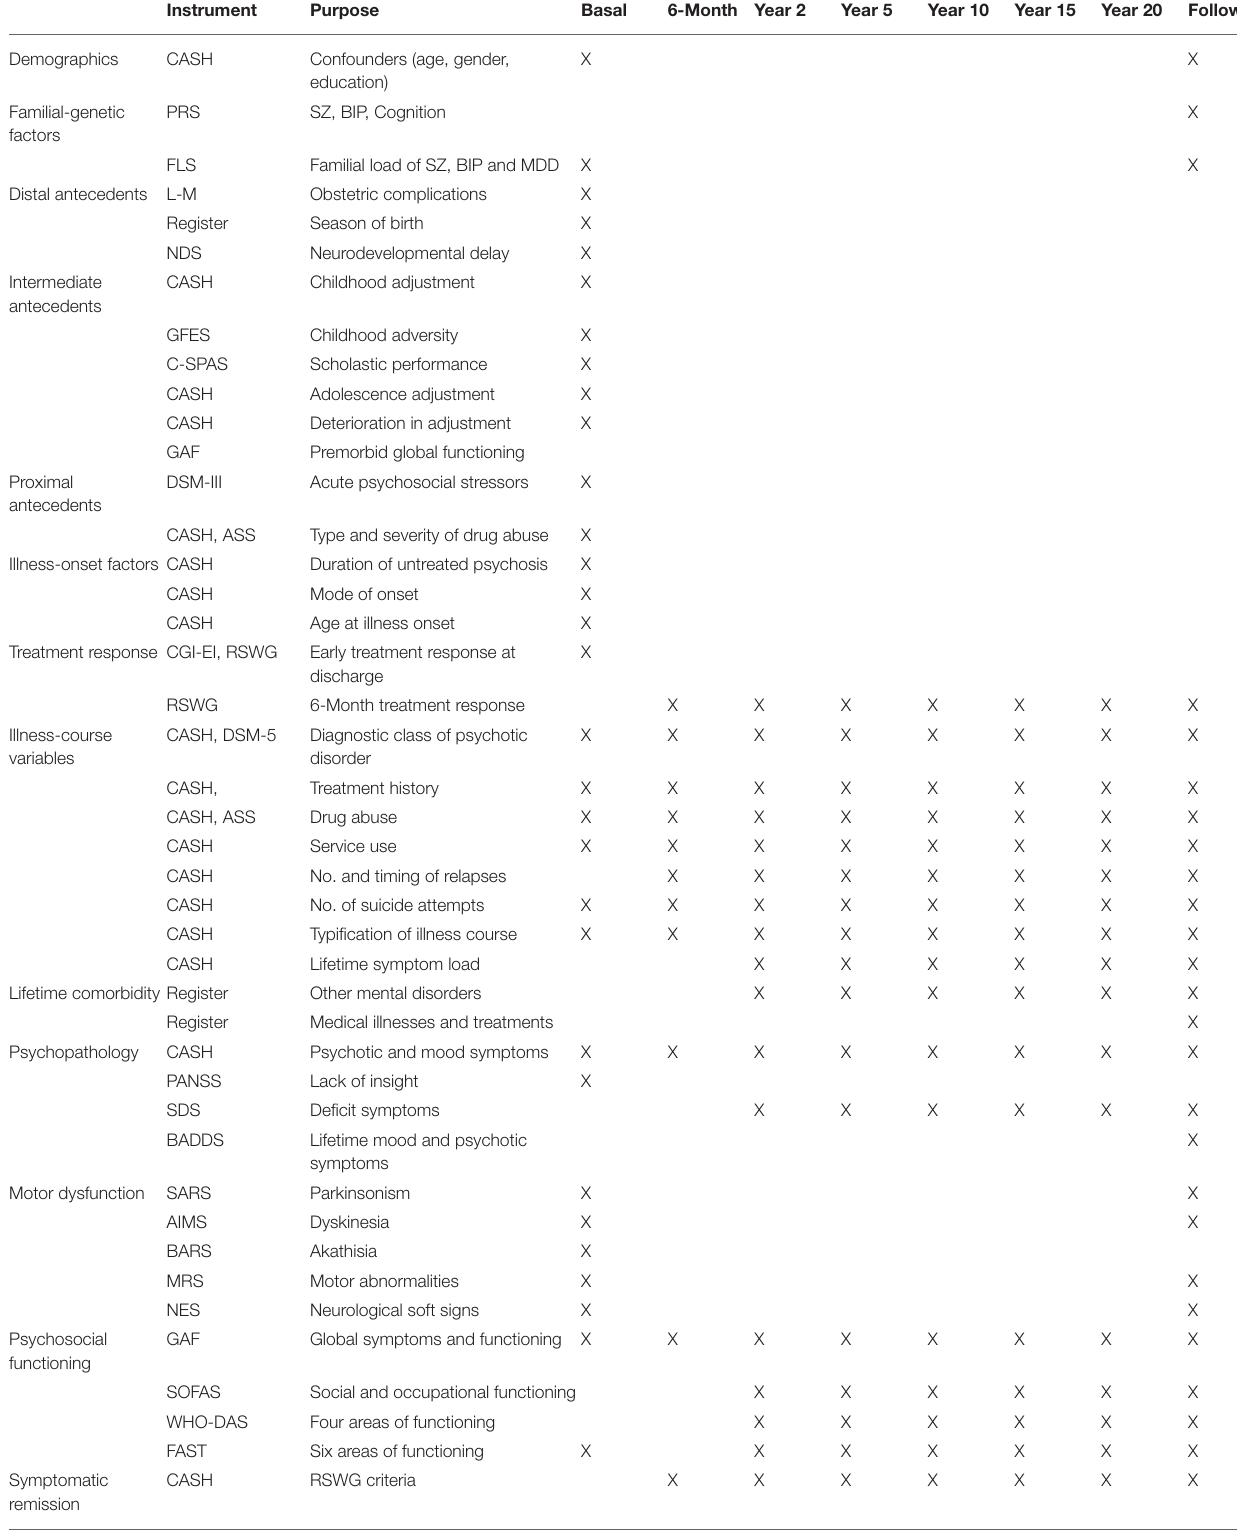
TABLE 1 | Overview of assessment instruments by